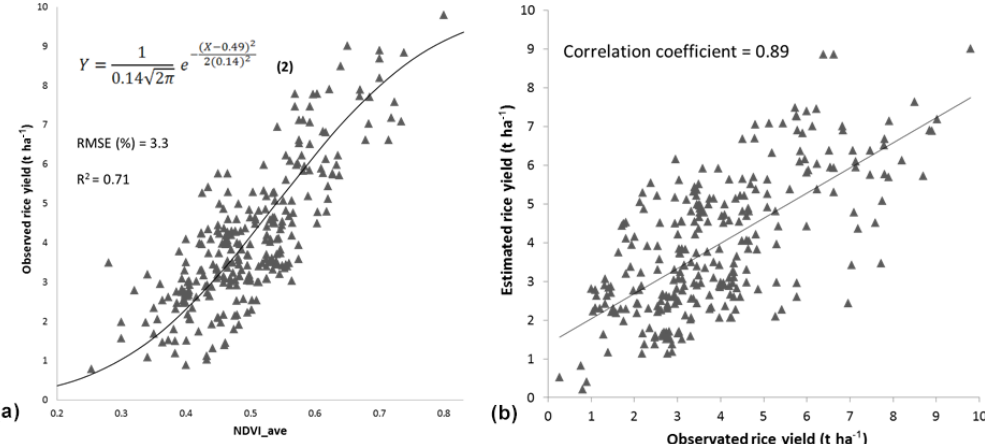
Figure 2. (a) Scatter plot of observed rice yield and NDVI_ave, curve of Eq. (1) for estimating yield (Valverde-Arias et al., 2019), and (b) correlation of observed and estimated rice yield. Table 2. Parameters of generalized-minimum extreme value (GEV min ) distribution for each AHZ and cantonal zone and distribution adjust- ment statistic of maximum likelihood.